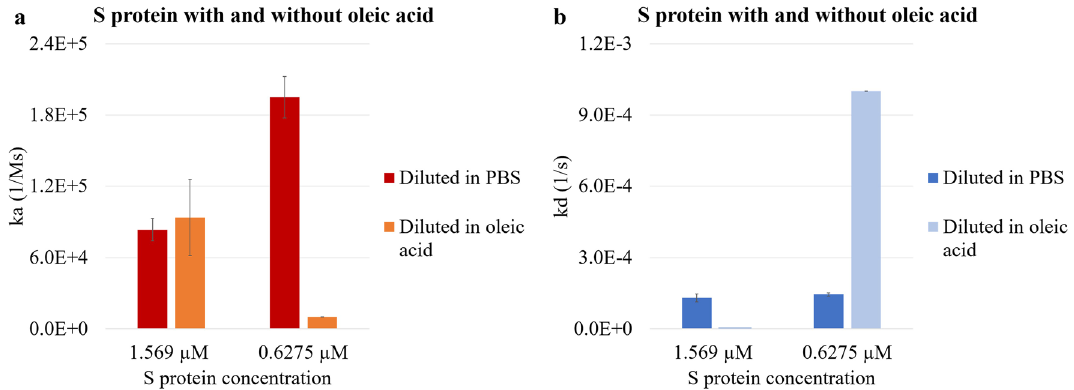
Figure 2. The effects of oleic acid on the attachment and detachment of S protein to and from the hydrophobic APS sensors. ( a ) The association constant ka and ( b ) dissociation constant kd of PBS diluted and oleic acid diluted S protein at 1.569 µM and 0.6275